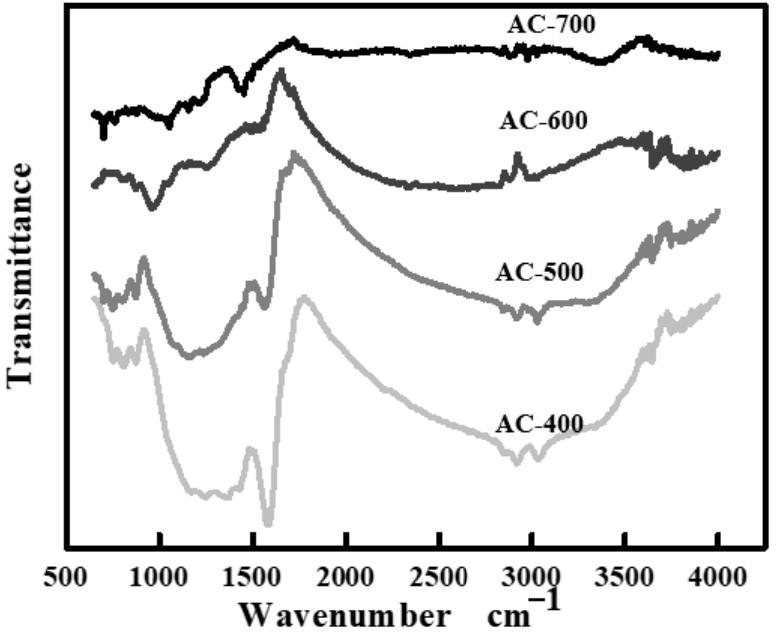
Figure 3. FT-IR spectra obtained for AC-400, AC-500, AC-600, and AC-700, as indicated.